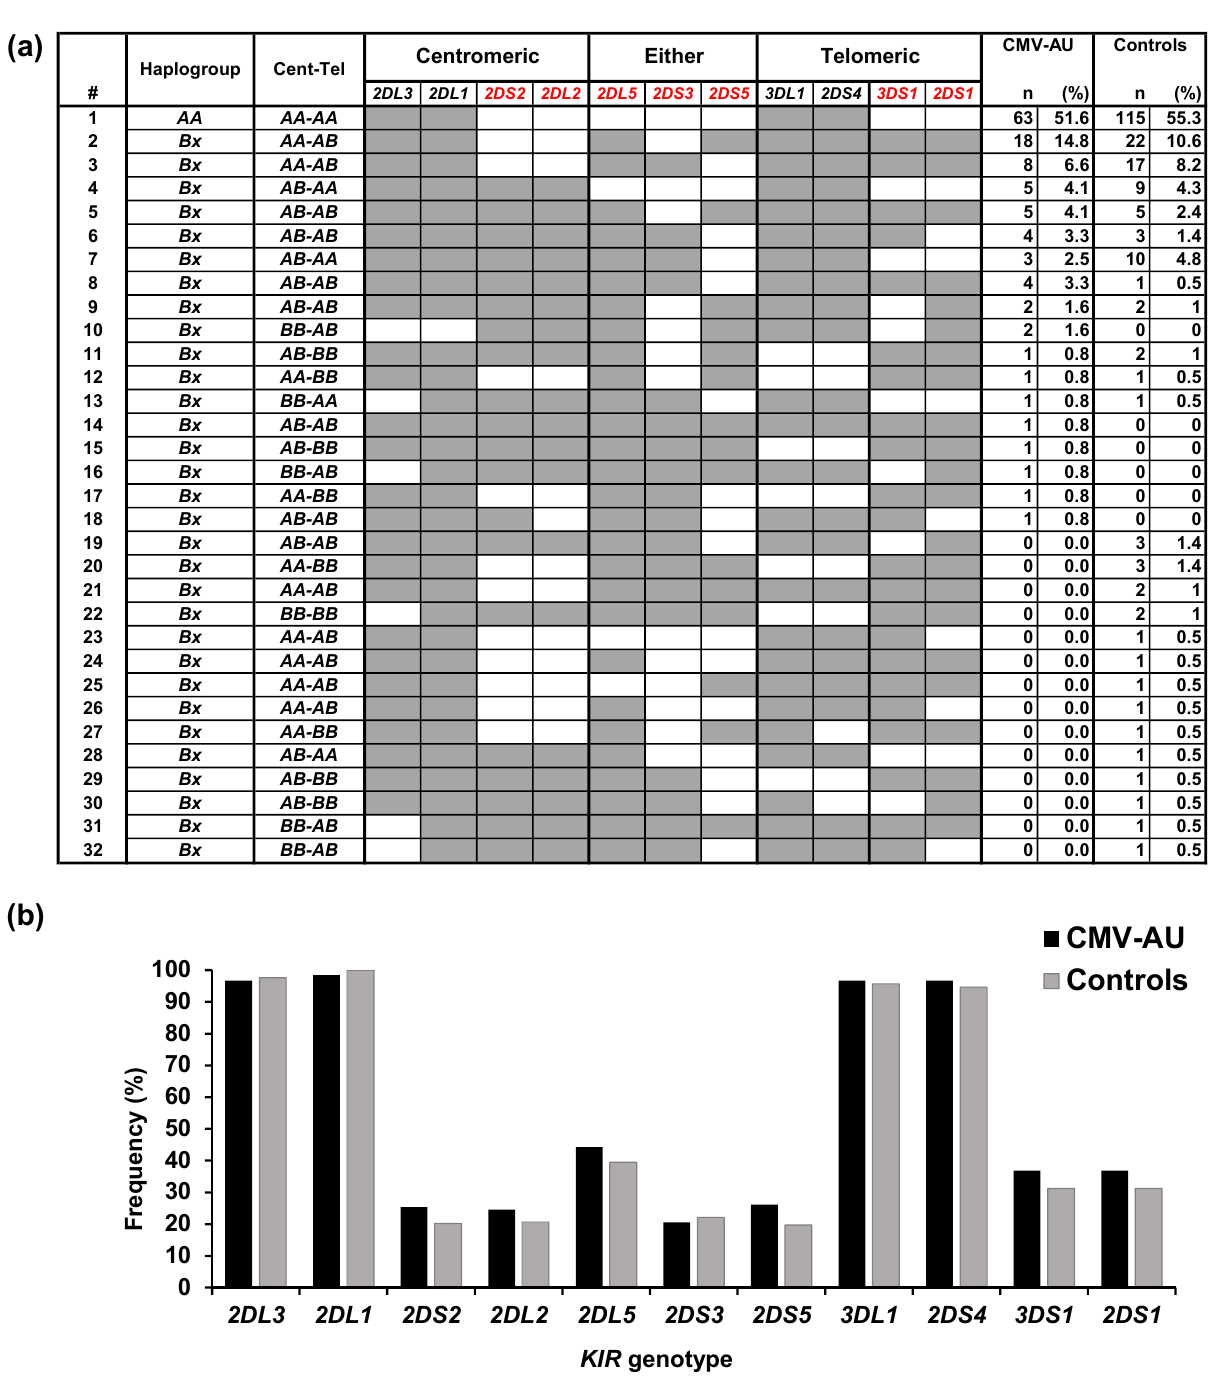
Figure 1. KIR genotypes in CMV-associated anterior uveitis (CMV-AU) patients and healthy controls. KIR genotypes ( a ) and gene frequencies ( b ) were determined in 122 individuals with CMV-AU. As a control, KIR genotypes in 208 healthy individuals of the same ethnicity (Chinese Singaporean) are shown from a previous study [25]. CMV-seropositivity was 87% based on a previous study in this population [26]. ( a ) Shaded boxes indicate presence of KIR genes. The centromeric/telomeric position of KIR loci indicated in columns 4 and 6 are their physical location within the KIR complex on chromosome 19 [27,28]. KIR2DL5 , KIR2DS3 , and KIR2DS5 genes can locate on either centromeric/telomeric sides of the KIR complex and are thus indicated in this table as such (column 5). KIR B haplotype-specific KIR genes are shown in red. KIR framework genes and pseudogenes are excluded. ( b ) Black and gray boxes indicate each KIR genotype frequency in CMV-AU and healthy controls,